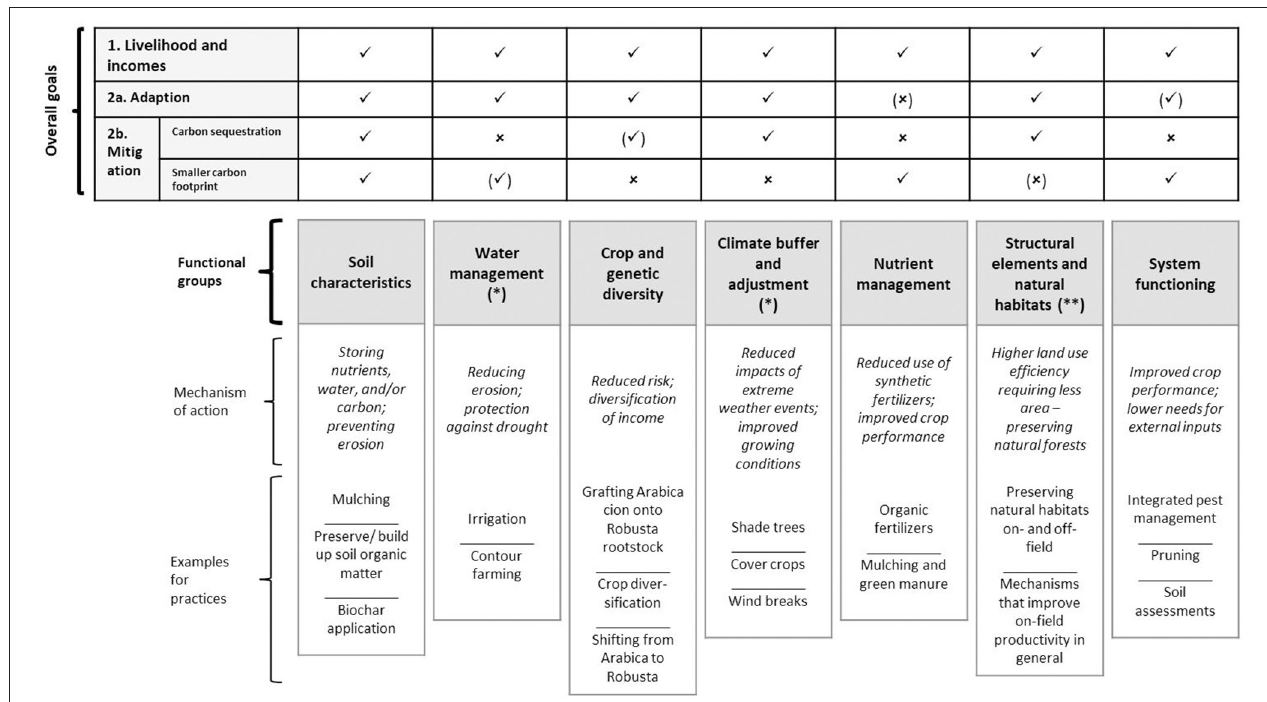
FIGURE 1 | Functional groupings of climate-smart practices in coffee farming. Top part of the table describes contribution to overall goals of climate-smartness. Mitigation action is additionally differentiated in carbon sequestration and carbon footprint reduction. In the bottom part, mechanism of action describes how functional groups deliver farm, landscape, and global benefits. Asterisk additional mark where landscape-wide adoption is of special importance for emerging effects to occur: (*) = improved effective scale is landscape wide adoption; (**) = optimum effective scale is landscape-wide adoption. Own